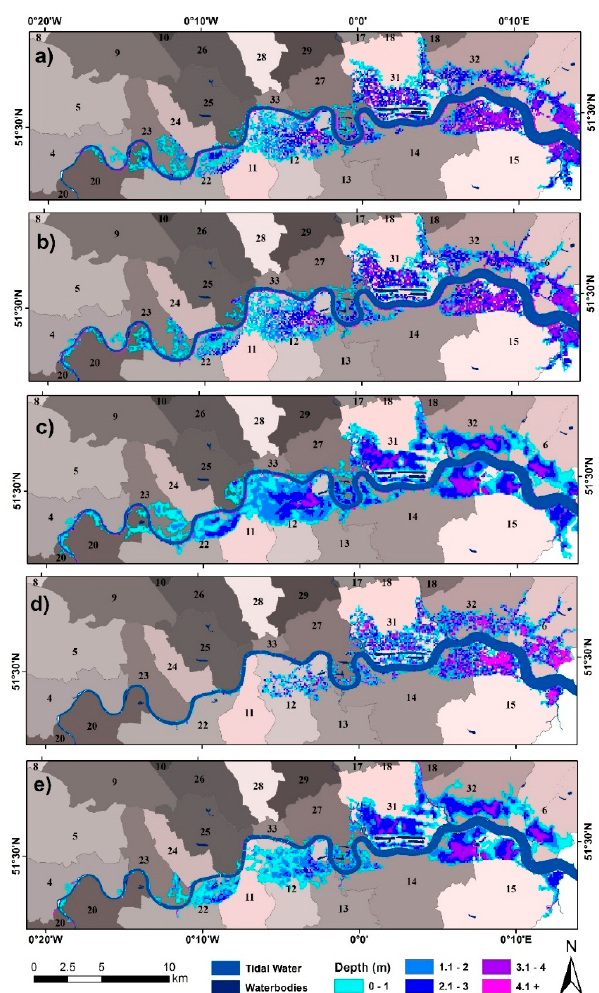
Figure 5. Flood depths obtained for inundated Greater London boroughs from the eight-way hydrological connectivity approach by UKCP09 sea-level rise scenario of 0.68 m. ( a ) 1 m LiDAR DEM; ( b ) 5 m LiDAR DEM Re ; ( c ) 5 m DEM; ( d ) 30 m SRTM DEM; and ( e ) 50 m DEM. Figure 1 gives the borough names that correspond to the numbers.